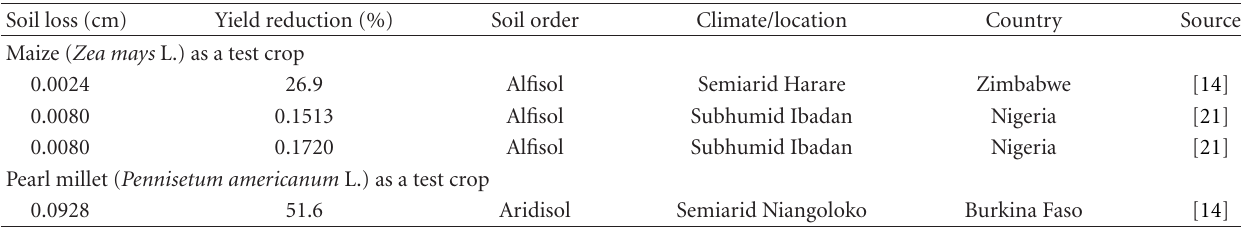
Table 2: Erosion-productivity relationship for soils of Sub-Saharan Africa (natural